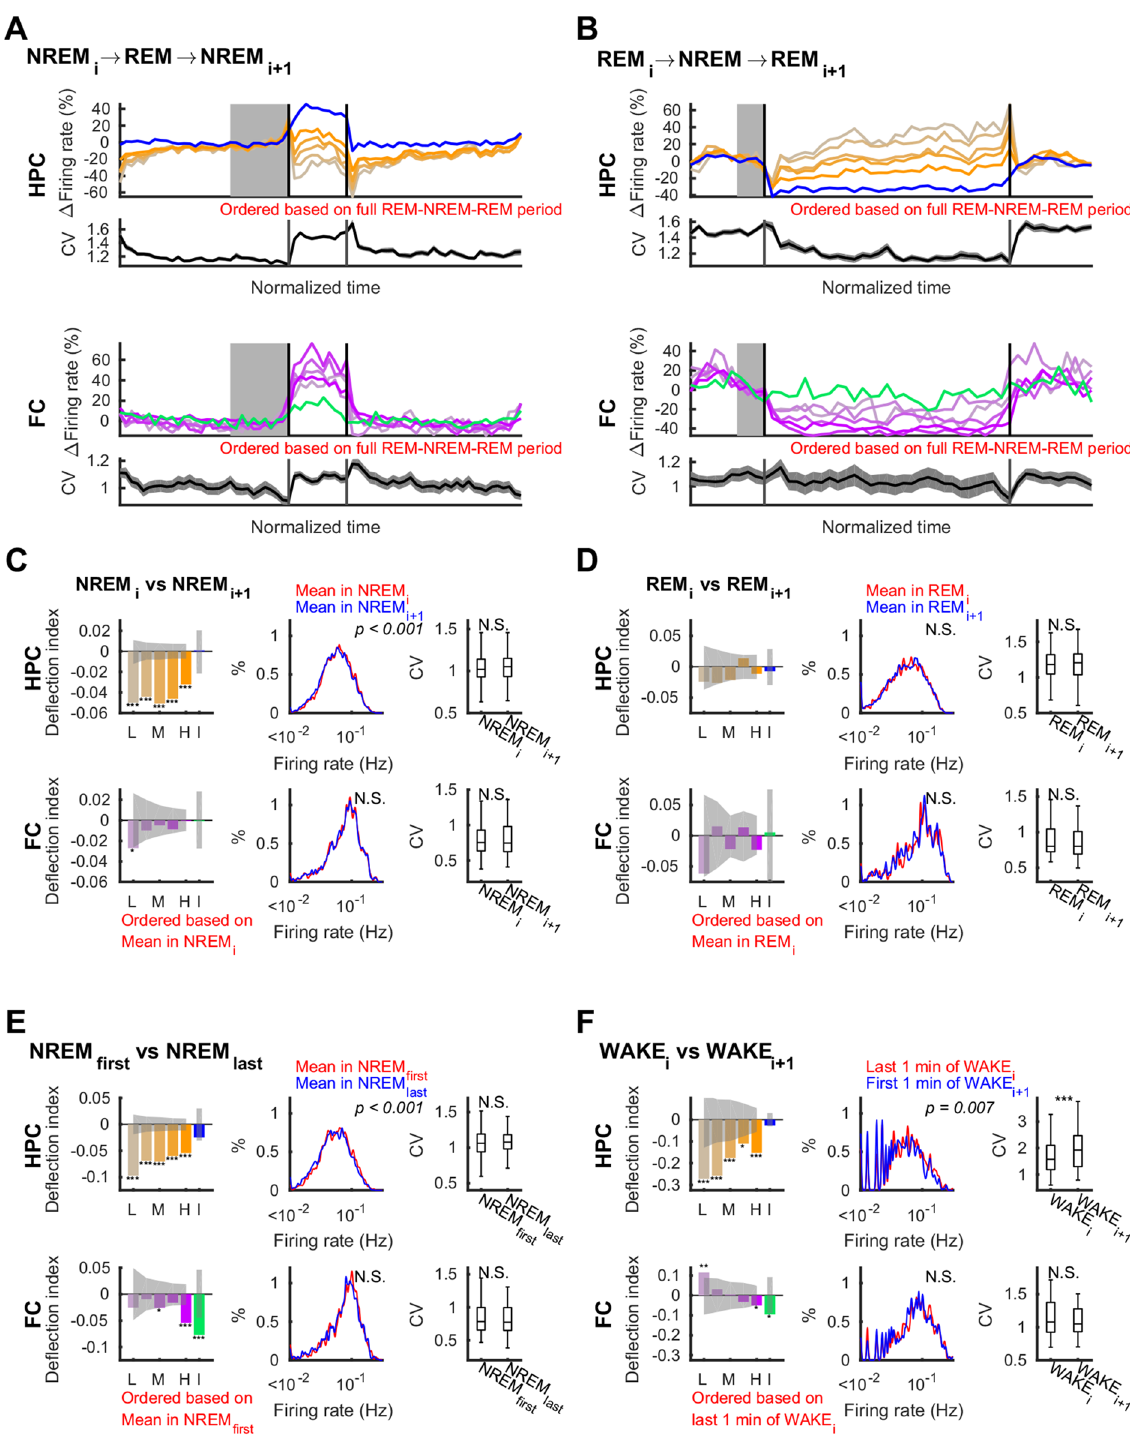
Figure 6. Net effects of sleep on neuronal firing distributions–analysis across state triplets. Effect of states as measured by net change from before to after that state. ( A , B ) Firing rates and coefficient of variation (CV) in the hippocampus (HPC; top panels) and in the frontal cortex (FC; bottom panels) in NREM i -REM-NREM i+1 triplets ( A ) and REM i -NREM-REM i+1 triplets ( B ) over time normalized for each epoch. Changes in firing rate of each quintile of pyramidal cells (orange shades) and interneurons (blue) in the hippocampus and frontal cortical principal neurons (purple shades) and interneurons (green) are relative to the mean of last third (shown in gray on the top panels and in blue on the bottom panels) of NREM i in ( A ) and last third of REM i in ( B ). ( C – F ) Deflection indices ( DI ), firing rate distributions, and CV of firing rates in ( C ) NREMs in NREM-REM-NREM triplets ( D ), REMs in REM-NREM-REM triplets, ( E ) between the first and last NREMs in each sleep, and ( F ) wake periods (last 1-min of WAKE i versus first 1 min of WAKE i+1 ) separated by sleep in the hippocampus (top rows) and in the frontal cortex (bottom rows). L: lowest quintile, M: middle quintile, H: highest quintile, I: interneurons. P-values of Kolmogorov–Smirnov tests are indicated on the middle panels. Changes in CV were tested with the Wilcoxon rank sum test. Error bars and line sheds indicate SEM, sheds on bars indicate 95% confidence intervals of shuffle mean, *p < 0.05, **p < 0.01, ***p < 0.001, N.S., not